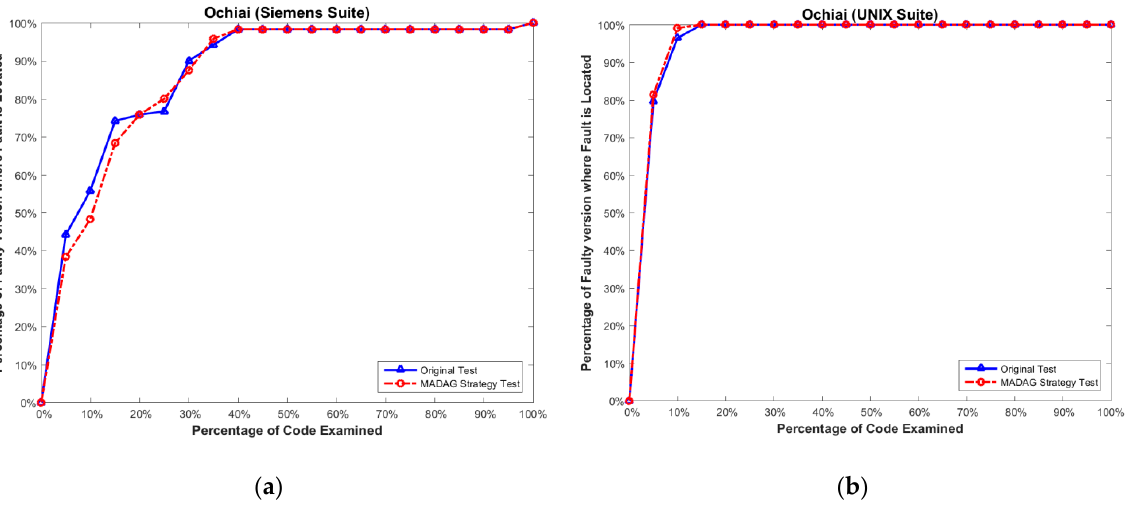
Figure 6. ( a ) Effectiveness comparison on the Siemens suite for Ochiai; and ( b ) on the UNIX suite for Ochiai.